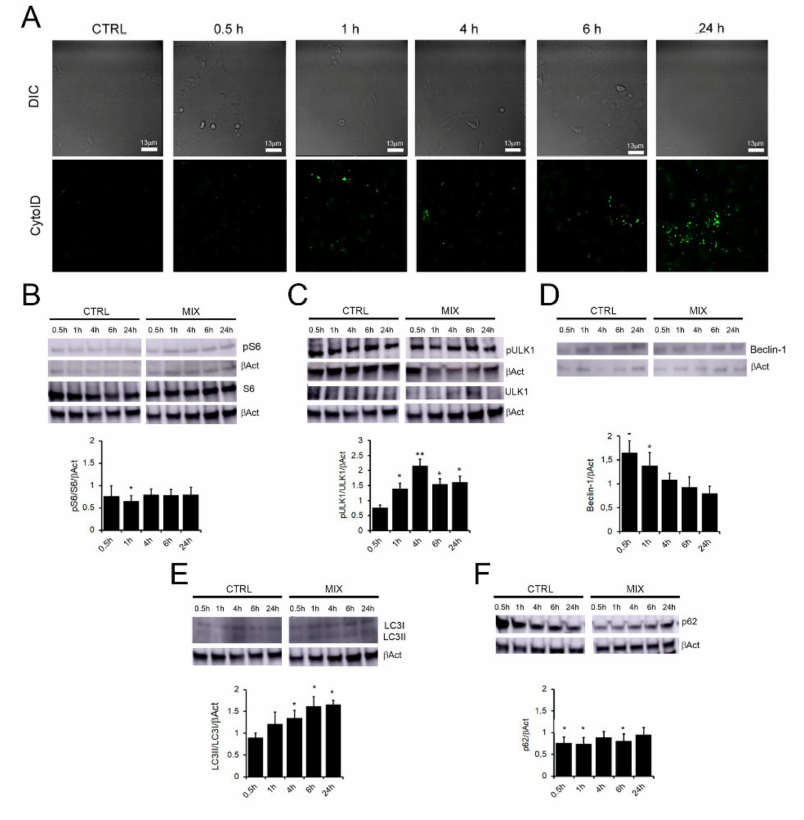
Figure 1. Autophagy detection in SH-SY5Y cells exposed to the MIX. ( A ) SH-SY5Y cells were treated with the OleA:HT mixture at the 1:1 molar ratio (37.5 µ M: 37.5 µ M) (MIX) for different lengths of time (0.5 h to 24 h). The autophagosomes (green) were labelled with the Cyto-ID ® fluorescent dye and the cells imaged by DIC transmission. ( B – F ): representative Western blots of all the assayed protein markers of autophagy: ( B ) p-S6/S6tot, ( C ) pULK/ULK, ( D ) Beclin-1 ( E ) LC3II/LC3I ratio and ( F ) p62. Quantification of signals was determined by densitometric analysis of at least three independent experiments normalized on β Actin ( β Act) signals. All the blot signals were normalized with the control untreated SH-SY5Y cells (CTRL). Error bars represent standard errors. *: p -value < 0.05; ** p < 0.01 vs. control untreated